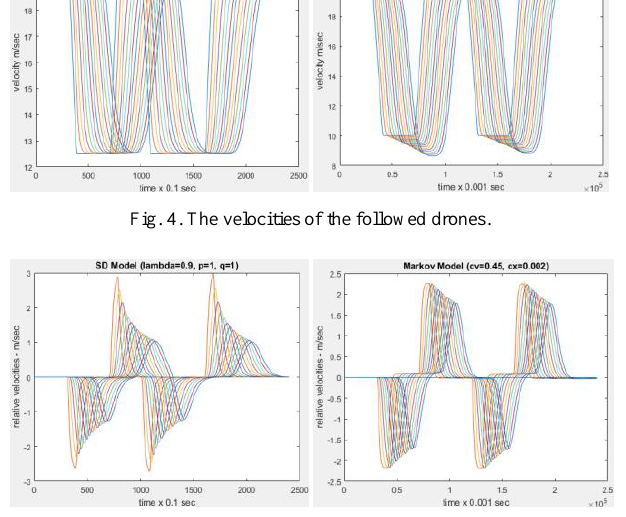
Fig. 5. The relative velocities of the followed